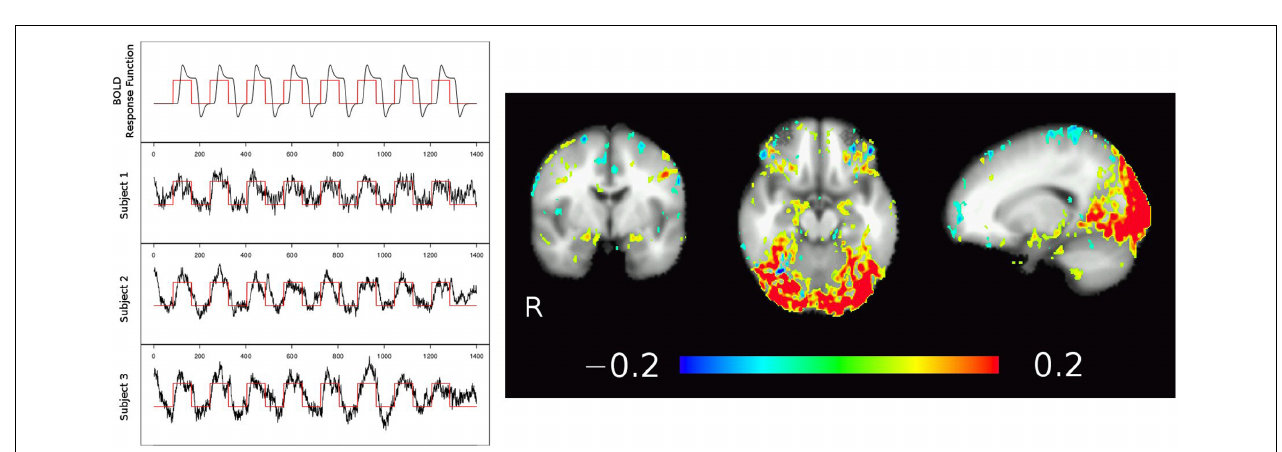
ROI chosen (motor, motor cortex; visual, visual cortex; amy, amygdala; wm, white matter; csf, cerebrospinal fluid; bs, brain stem). Note that while tSNR is increased compared to standard EPI when using a multiband factor of 4, it is however, decreased at a multiband factor of 8.